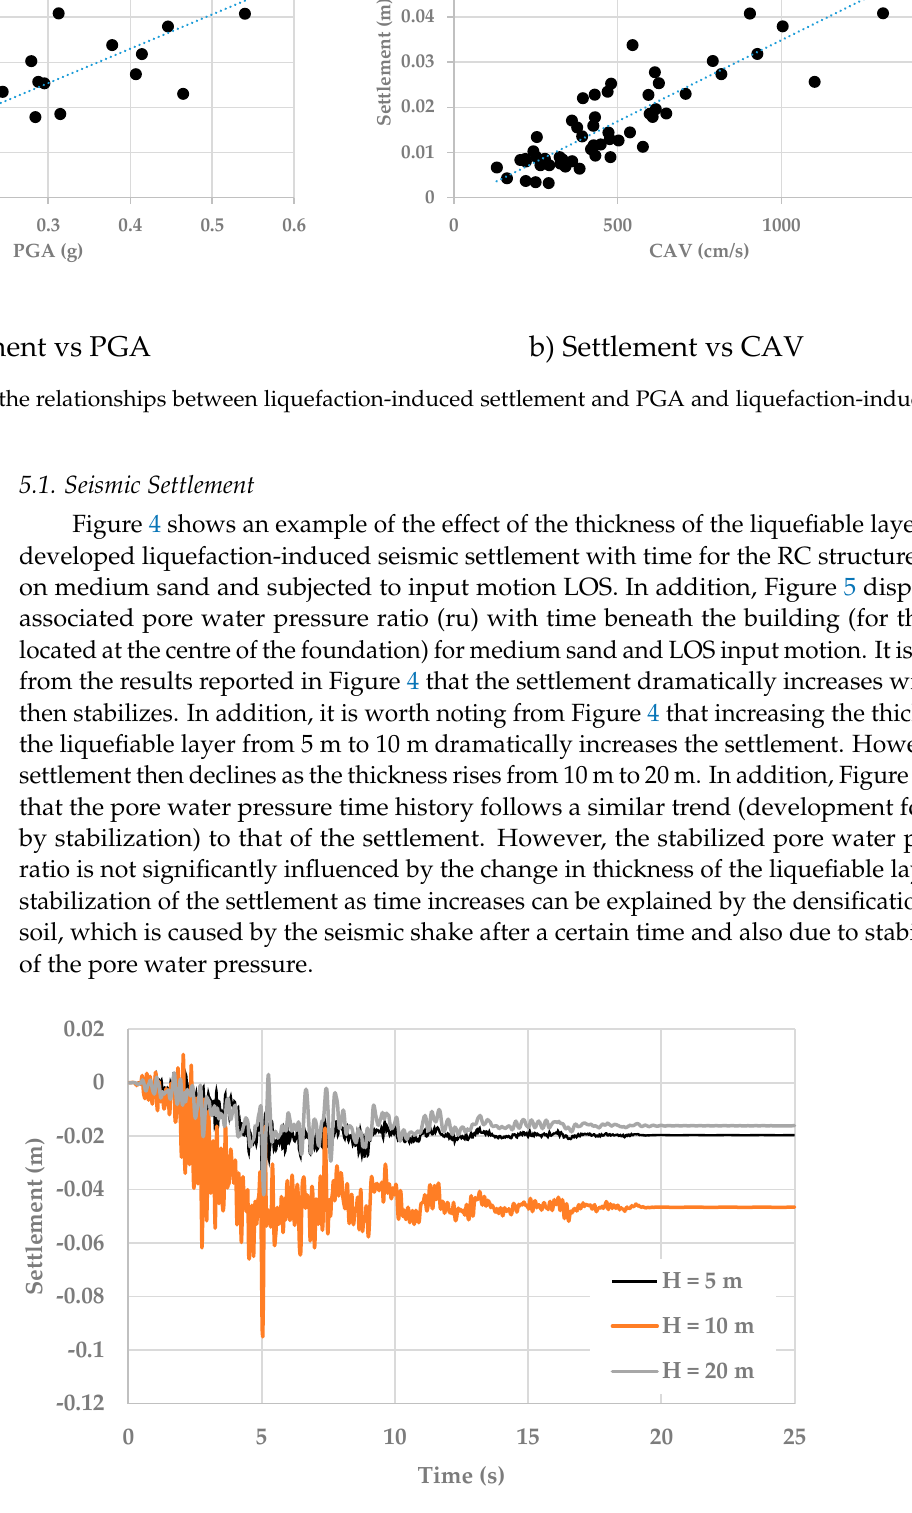
Figure 4. Effect of the thickness of the liquefiable layer on the liquefaction-induced settlement-time history for the case of a building resting on medium sand and subjected to LOS earthquake shake.